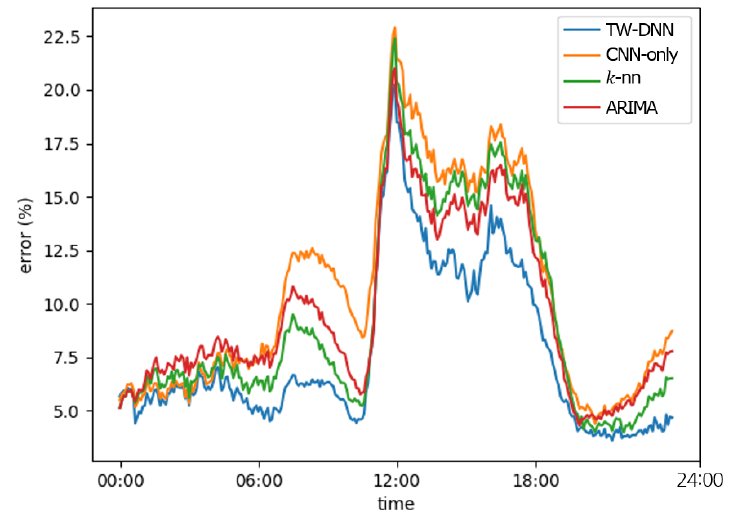
Figure 10. MAPE error of prediction models for Case II.